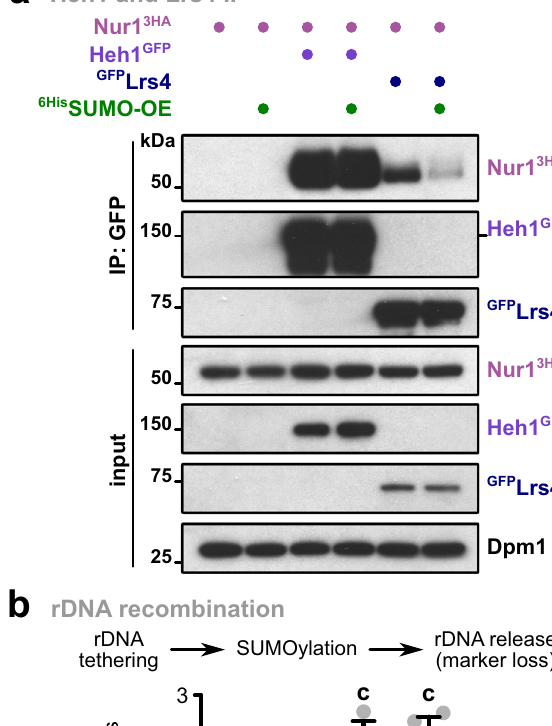
Fig. 4 SUMO overexpression promotes CLIP-cohibin disassembly and rDNA release and recombination. a Co-immunoprecipitation of Nur13HA with Heh1 GFP or GFP Lrs4 in cells expressing SUMO at endogenous levels or overexpressed from the ADH1 promoter ( 6His SUMO-OE). Dpm1 served as loading control. b Rates of rDNA recombination in WT ( n = 4) or lrs4 Δ ( n = 3) cells expressing SUMO at endogenous levels or overexpressed